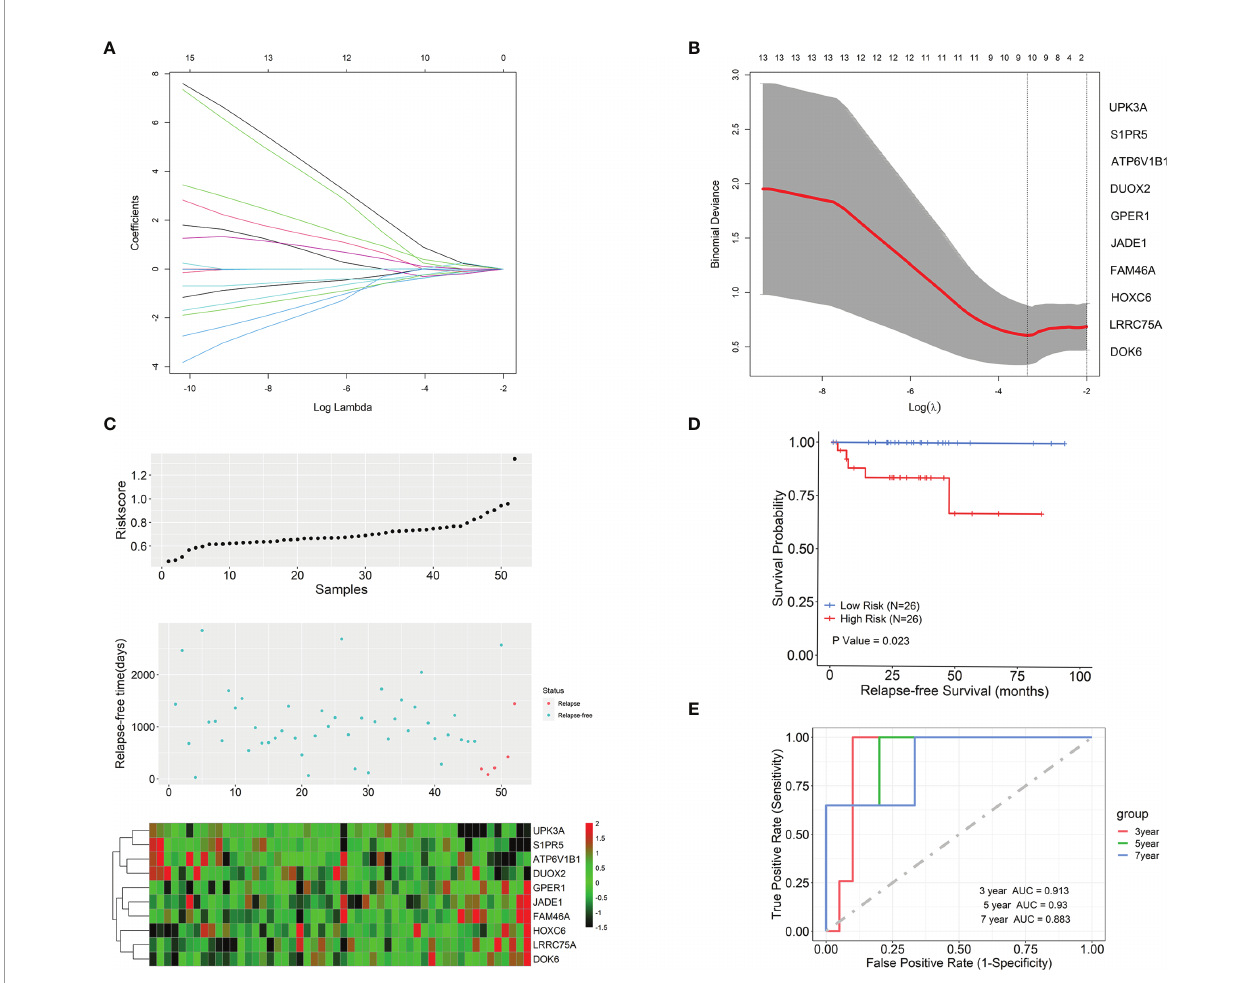
FIGURE 4 | The development of the prognostic model based on gene expression pro fi les in tumor microenvironment (TAN) samples and the evaluation of this model. (A) LASSO coef fi cient pro fi les of the 10 prognostic TAN-related genes. (B) Selection of the optimal lambda in the LASSO model. (C) The risk score, survival status, and expression abundances of the 10 genes based on the TAN samples in TCGA-PRAD project. (D) Kaplan-Meier survival analysis in terms of BCR-free survival for the high- and low-risk patient groups. (E) The ROC analysis for the prediction of the 3-, 5-, and 7-year BCR-free survival based on the risk scores calculated by the 10-gene prognostic